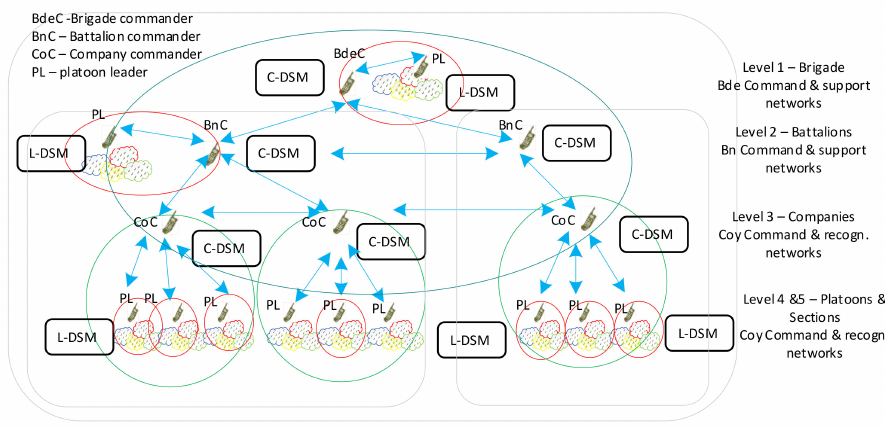
Figure 4. General architecture of DSM in